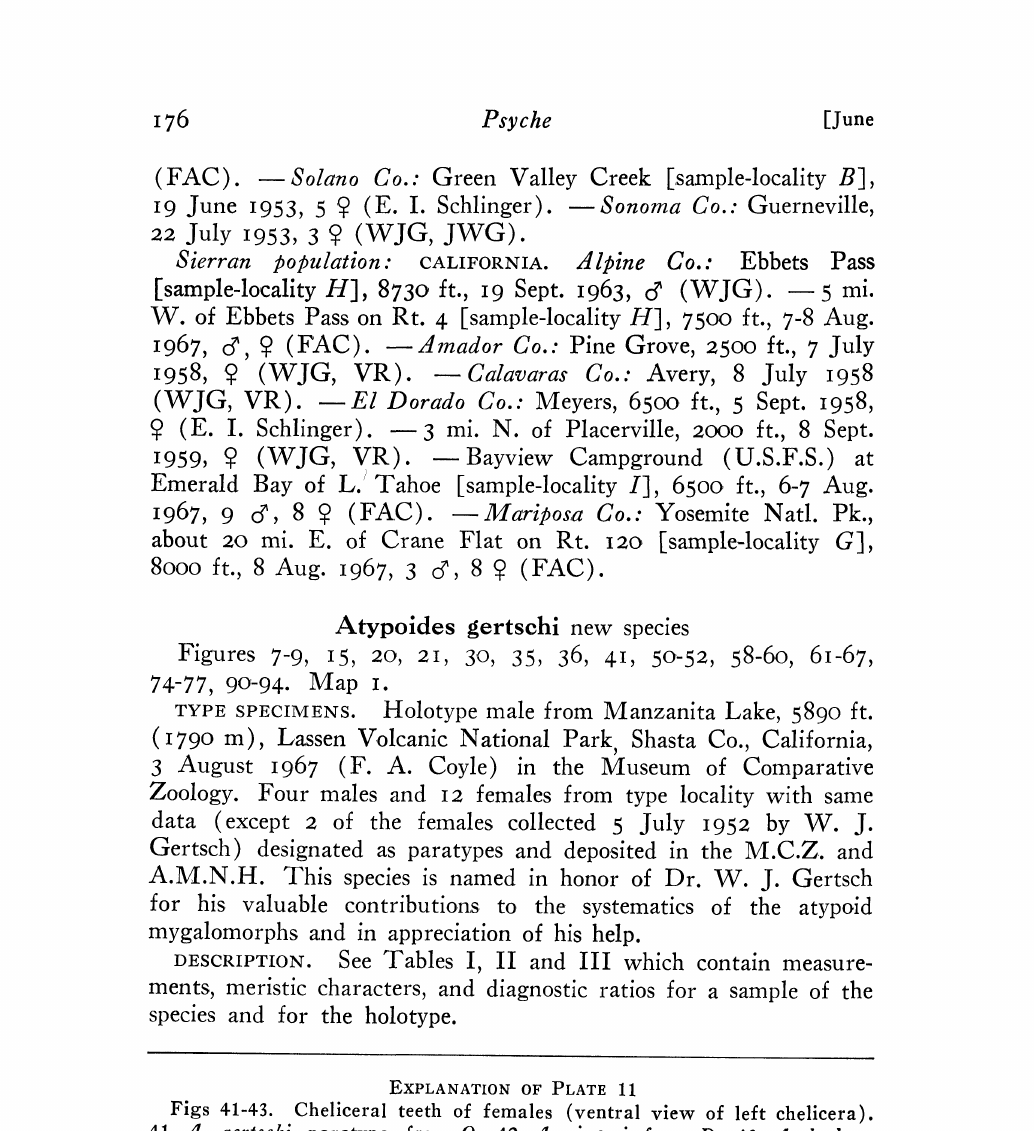
Figs. 44-45. Left palpal tarsus of 2/. rver$ (retrolateral aspect of dorsal surface). 44. 9, rom D. 4. penultimate 3, rom F. [2.0 mm scale line $or 44-45.] Figs. 45-52. Chelicerae of males (ectal view of dissected left chelicera without i:ang). 45. 2/. hadro$, ho|otype. 47-49. 2/. rer$i. 47. lectotype. 48. rom F. 49. rom I. 50-52. 2/. gert$chL 0. rom P. 51. paratype, rom O. 52. rom M. [2.0 mm scale line or